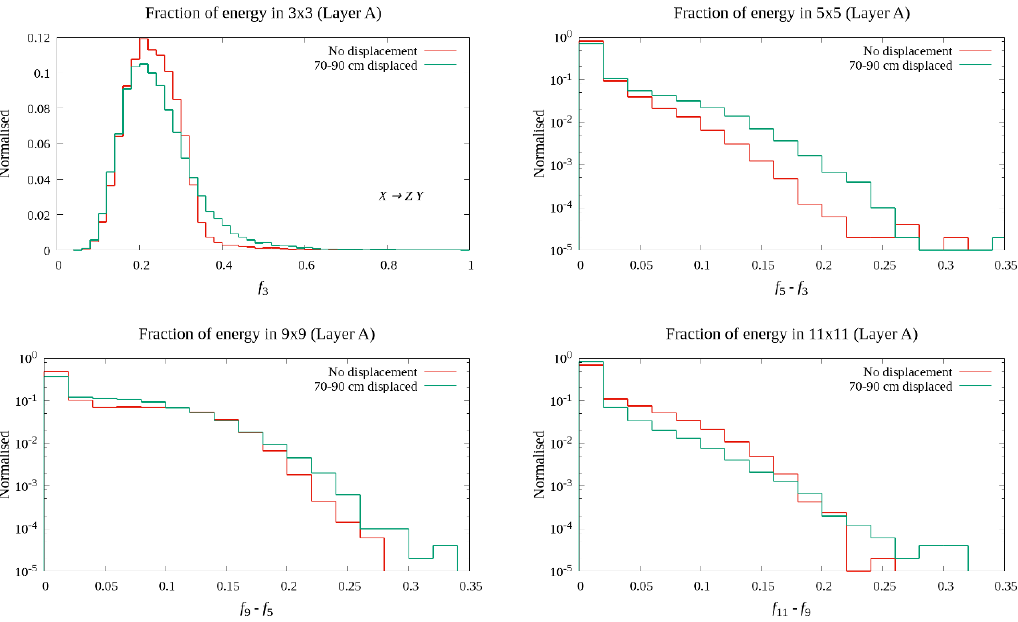
Figure 15. Normalised distributions of energy deposition fraction ( f i ) with varying sizes of blocks ( i (cid:2) i ) for the non-displaced and 70{90 cm displaced Z boson in layer A.